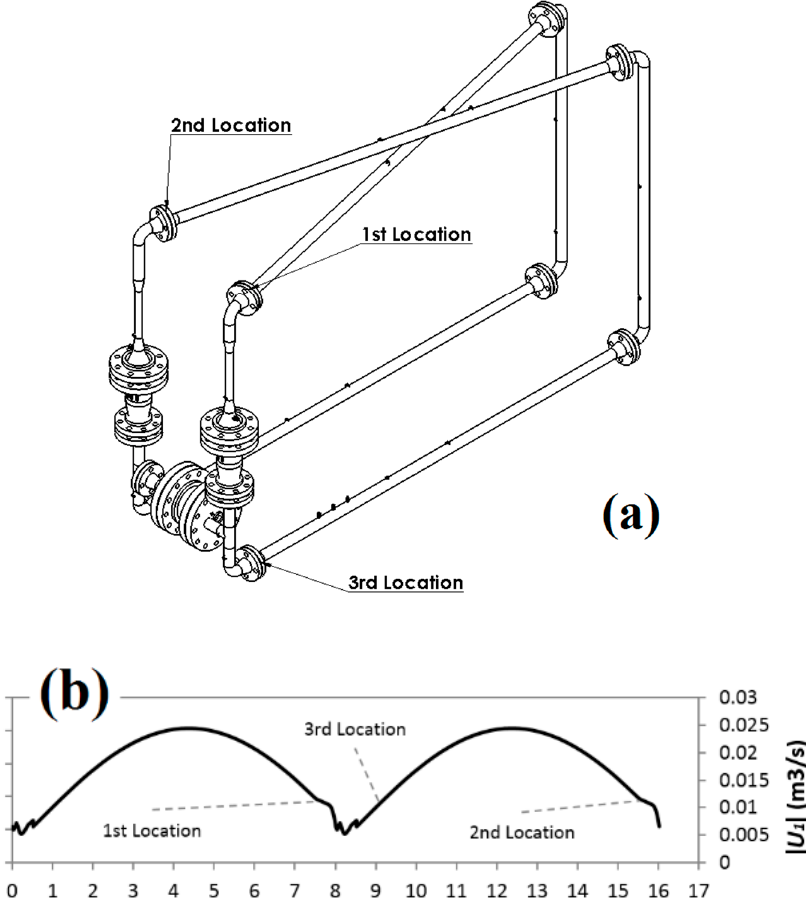
Figure 13. ( a ) Locations of the membrane along the engine loop; ( b ) locations of the membrane on the volumetric flow rate graph.